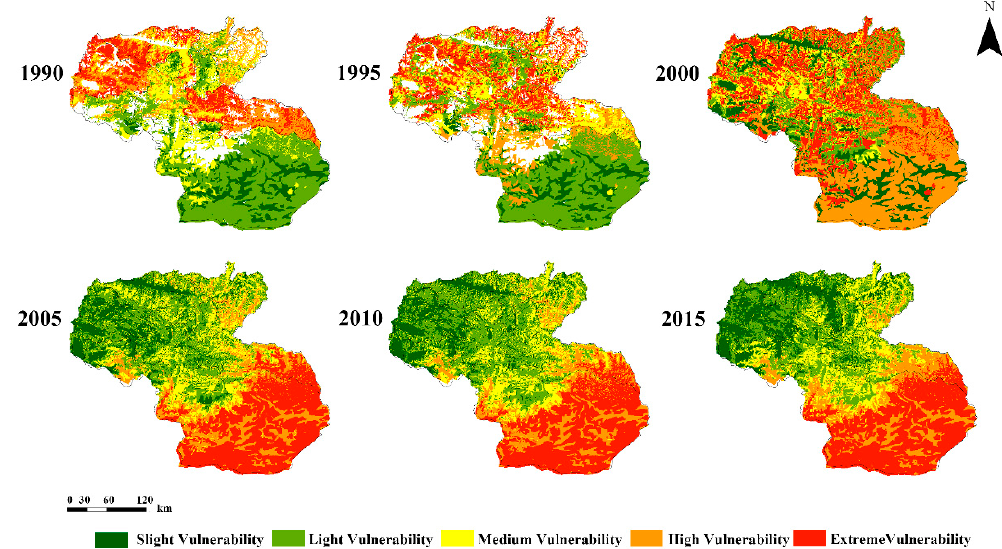
Figure 4. The EVI distribution of Shannan in 1990–2015. Figure 4. the EVI distribution of Shannan in 1990–2015.